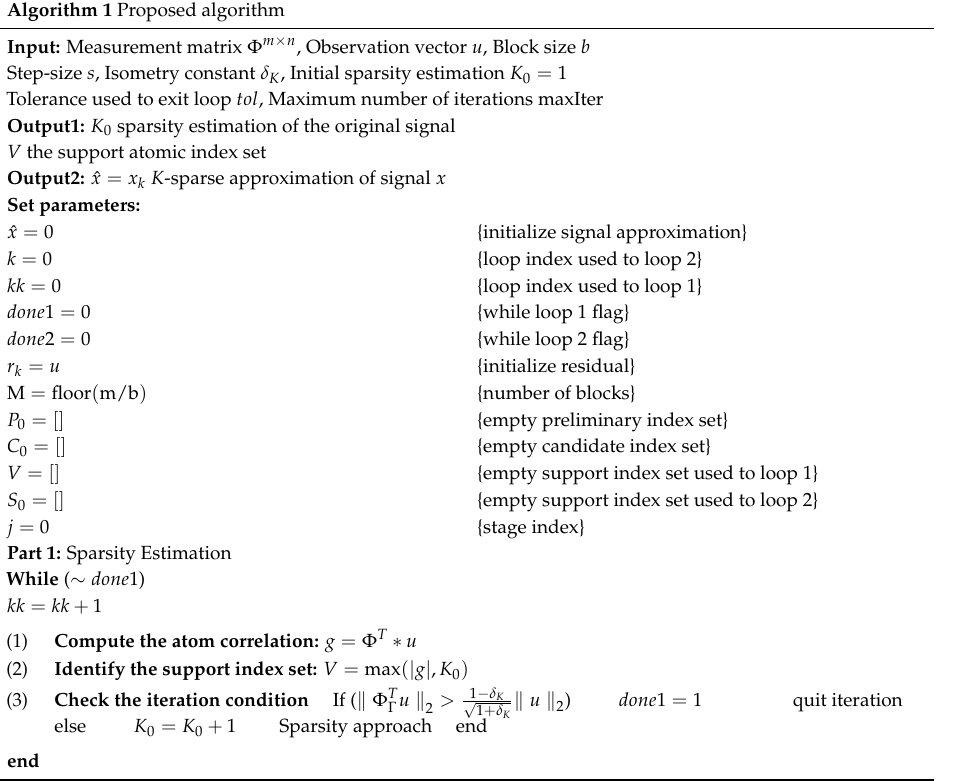
Table 1. Proposed algorithm.